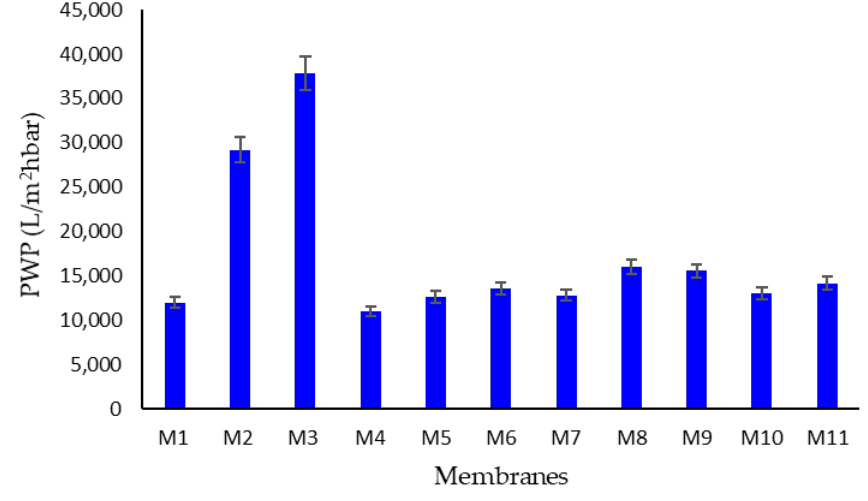
Figure 8. Water permeability (PWP) of prepared ENMs.